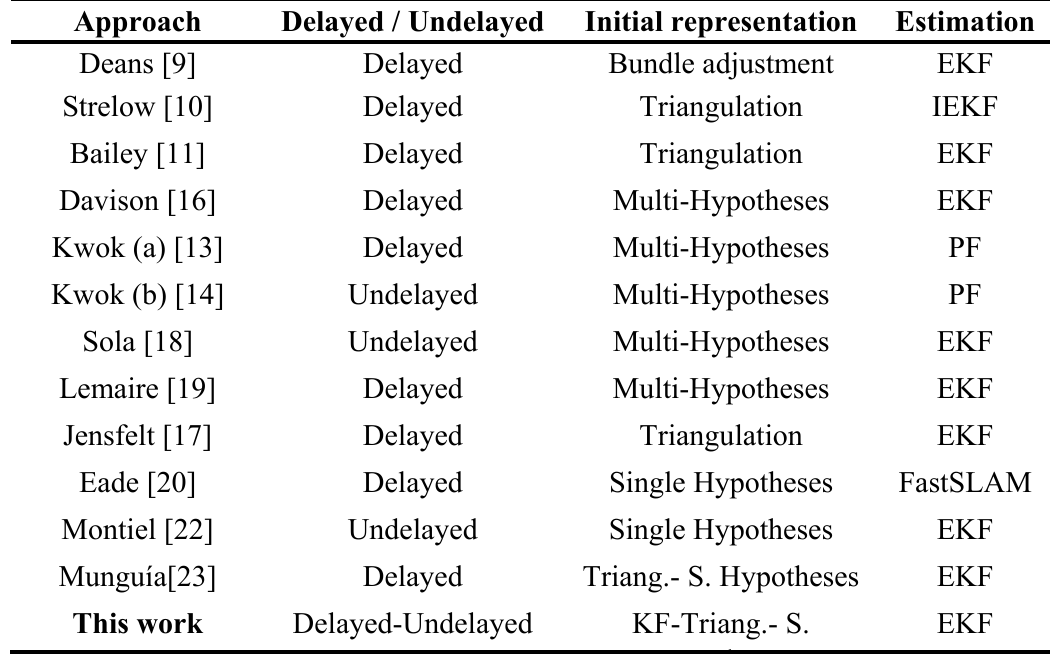
Table 1. Summary of